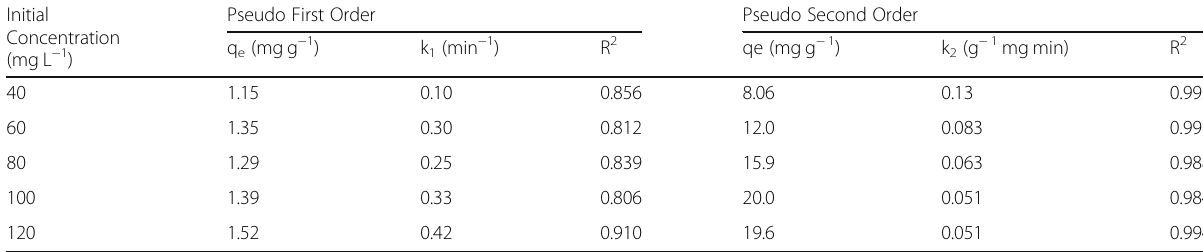
Table 2 Adsorption parameters of kinetic models for pseudo first order and pseudo second order for the adsorption of RB-21 onto MMCC Initial Concentration (mg L − 1